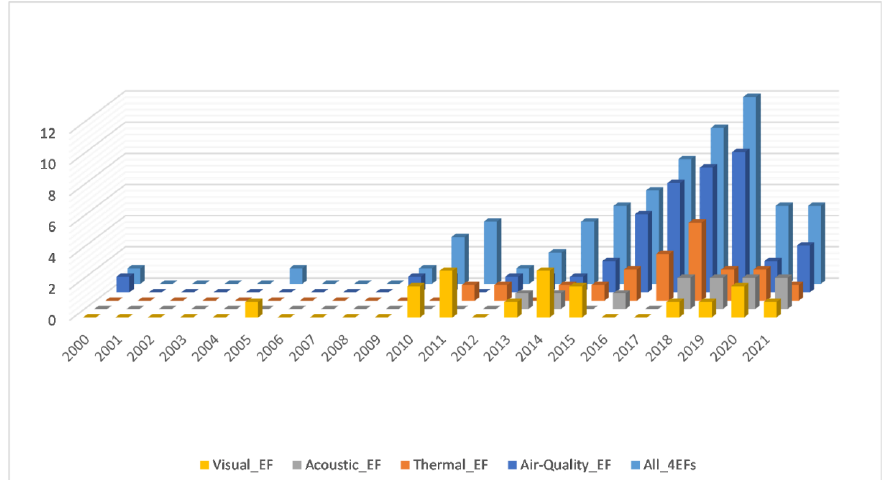
Figure 5. Annual Scientific production — Scopus, 2021.